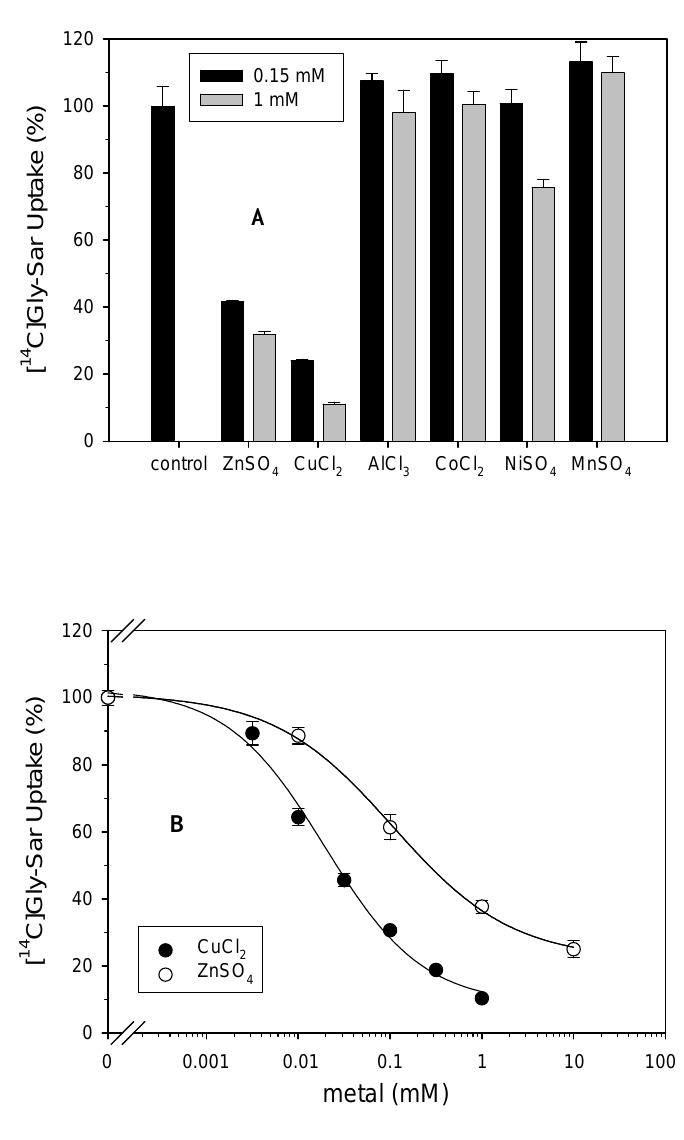
Figure 1. Effect of different metals salts on [ 14 C]Gly-Sar uptake in Caco-2 cells. A : Uptake of [ 14 C]Gly-Sar (10 µM) was measured in Caco-2 cells (pH 6.0, 10 min, n = 3 - 4) in the absence and presence of different metals salts (0.15 and 1 mM). Uptake of [ 14 C]Gly- Sar measured in the absence of the inhibitors was taken as 100% (control). B : Uptake of [ 14 C]Gly-Sar (10 µM) was measured in Caco-2 cells (pH 6.0, 10 min, n = 3 - 4) in the presence of increasing concentrations of ZnSO and CuCl (0–10 mM). Uptake of Gly- 4 2 Sar measured in the absence of inhibitor 107 ± 23 and 19 ± 5 µM for [ 14 C]Gly-Sar in presence of zinc and copper,